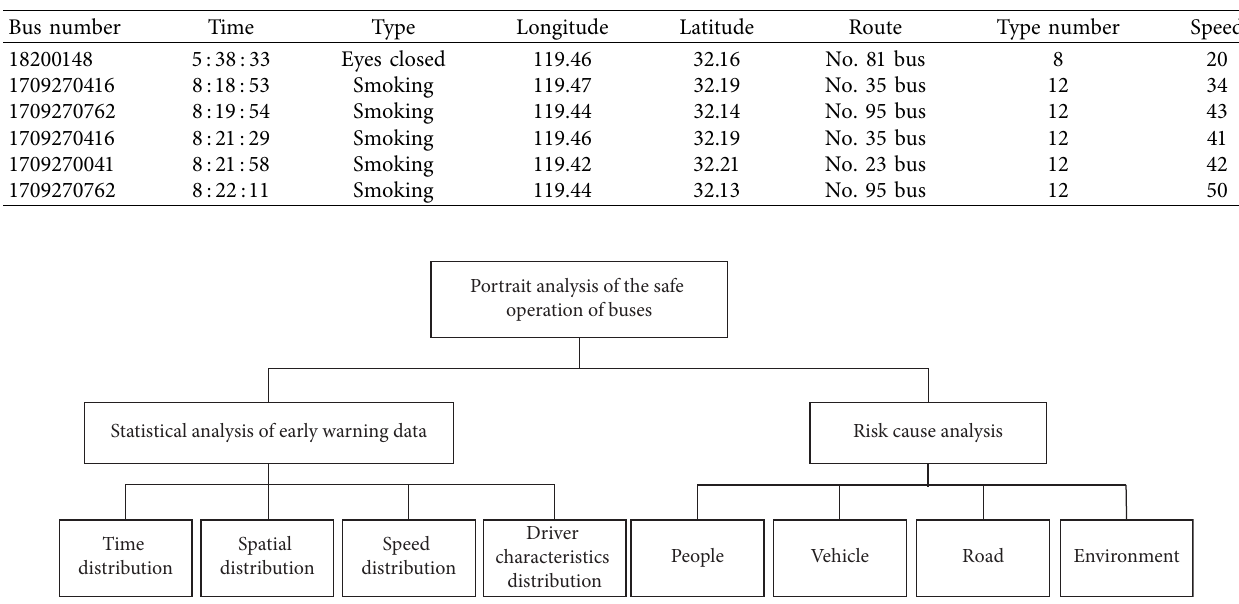
Figure 3: Portrait analysis of the safe operation of